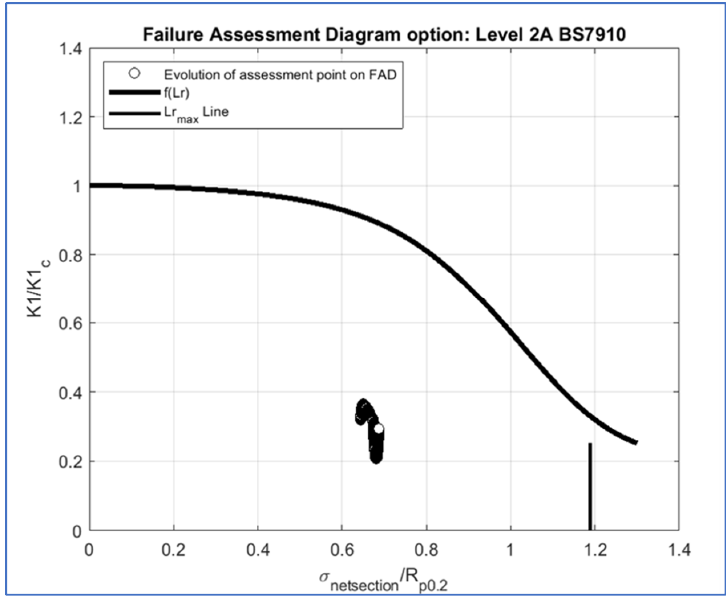
Figure 26. Failure assessment diagram (FAD) of the cracked component.